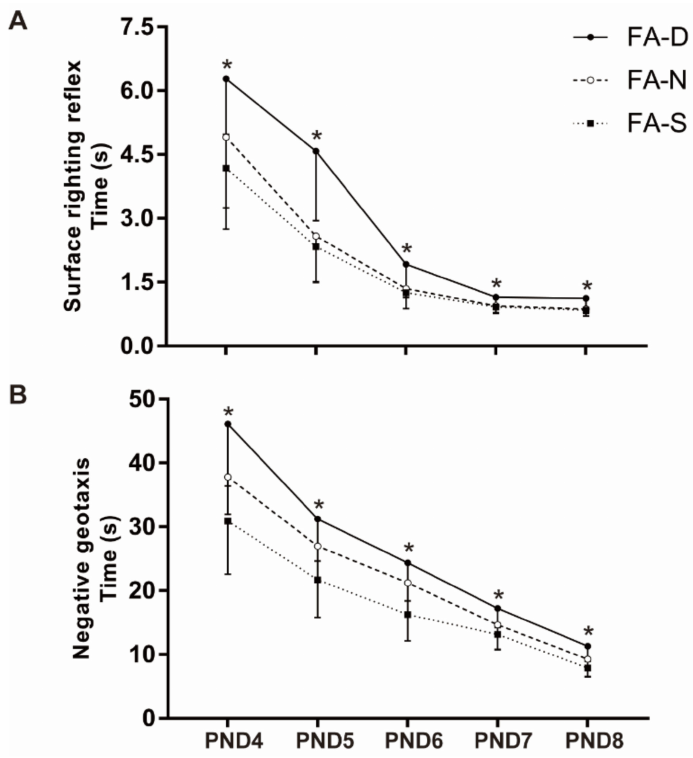
Figure 2. Folic acid supplementation improved sensory-motor function in infant offspring. Dams and pups were fed as described in Figure 1. Sixteen pups were selected randomly from each diet group (3–4 offspring from each dam) at PND4 and used for 5 consecutive days of righting reflex on the surface and negative geotaxis test. ( A ) Righting reflex on the surface for offspring. ( B ) Negative geotaxis test for offspring. Data are expressed as mean ± SD ( n = 16 offspring for each group). * Comparing with three groups at α = 0.05/(comparison times).